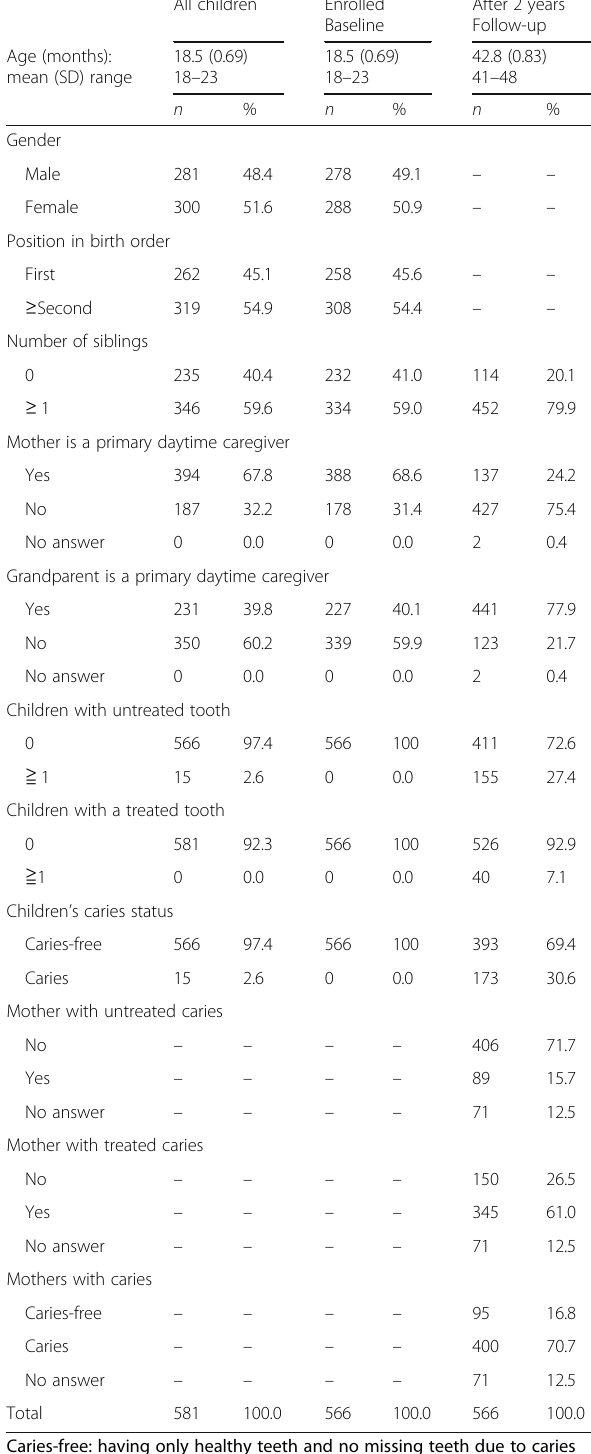
Table 1 Characteristics of children enrolled at baseline in checkups for 18-month-olds